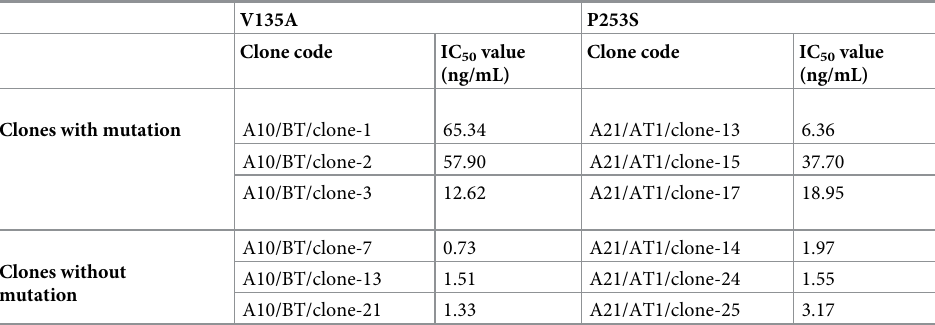
Table 4. IC 50 values of A10/BT and A21/AT1 clones with substitutions V135A and P253S.